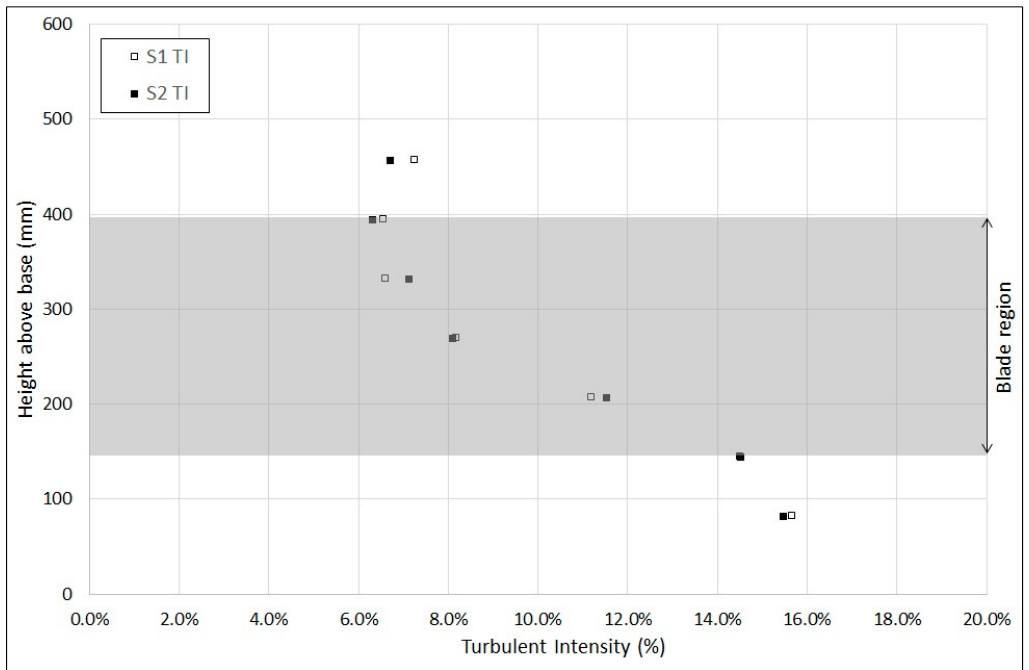
Figure 11. Turbulent intensity recorded at blade plane. S1 and S2 support structures, nacelle in place, blades removed (4096 samples at 25 Hz per point).